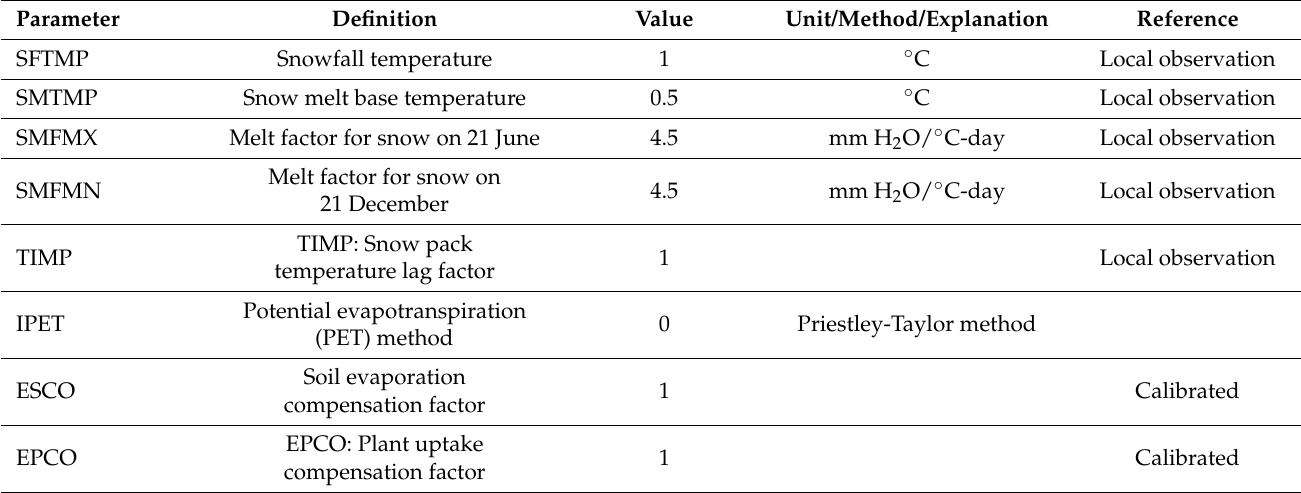
Table 1. Major input parameter values used for the ACFRB-HAWQS